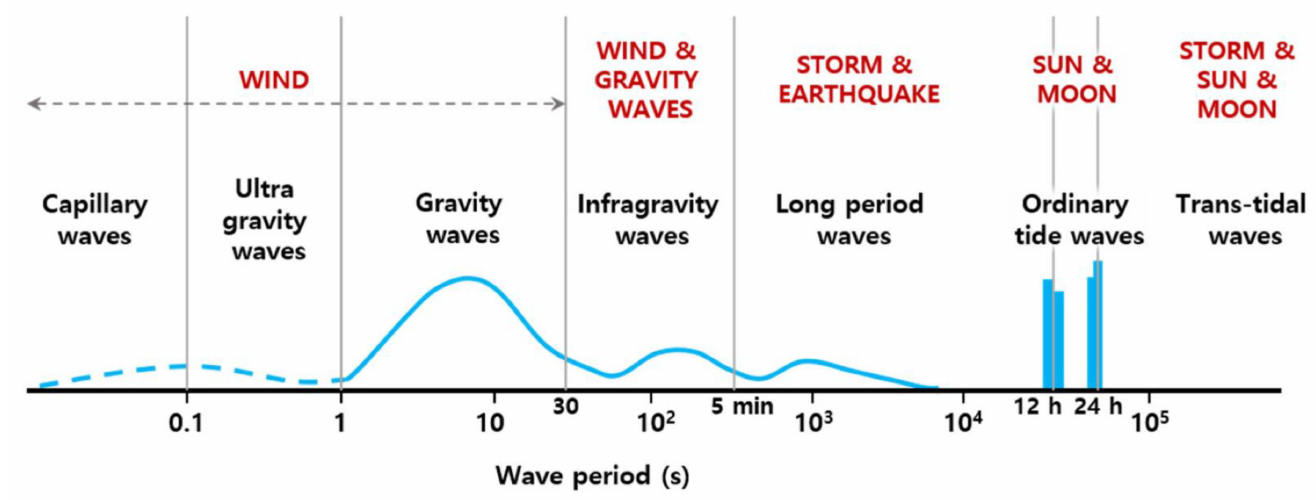
Figure 1. Classification of the spectrum of ocean waves according to wave period